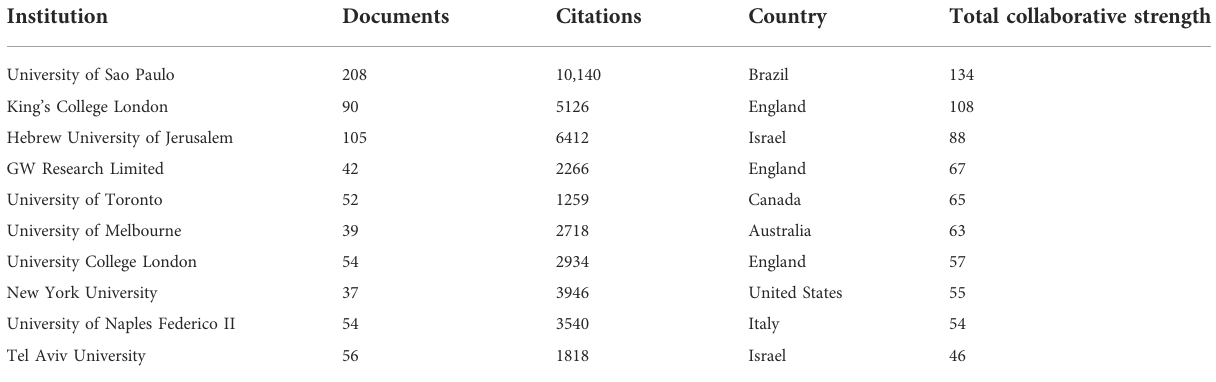
TABLE 1 The top 10 most collaborative institutions.